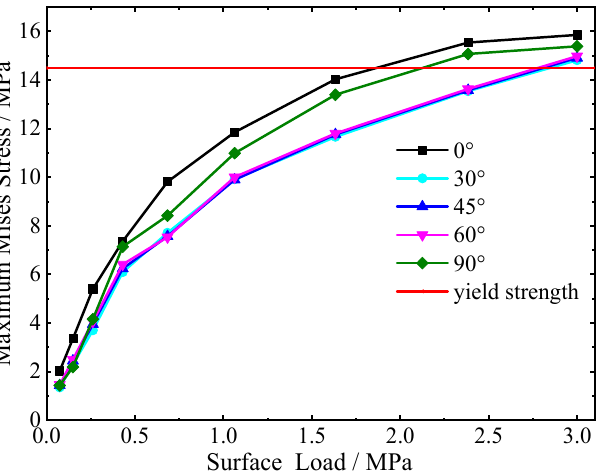
Figure 11. Maximum von Mises stress in HDPE pipeline with different defect locations.